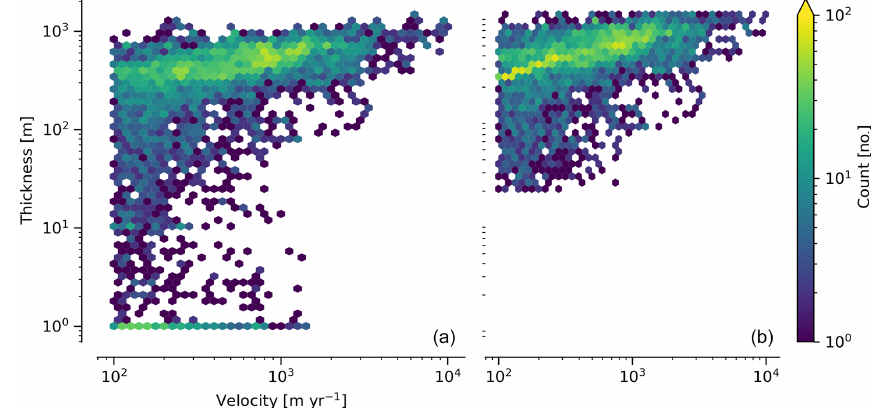
Figure 3. 2-D histogram of velocity and thickness at all gate pixels. (a) Unadjusted (BedMachine and Millan et al., 2018) thickness. (b) Adjusted (as described in the text)